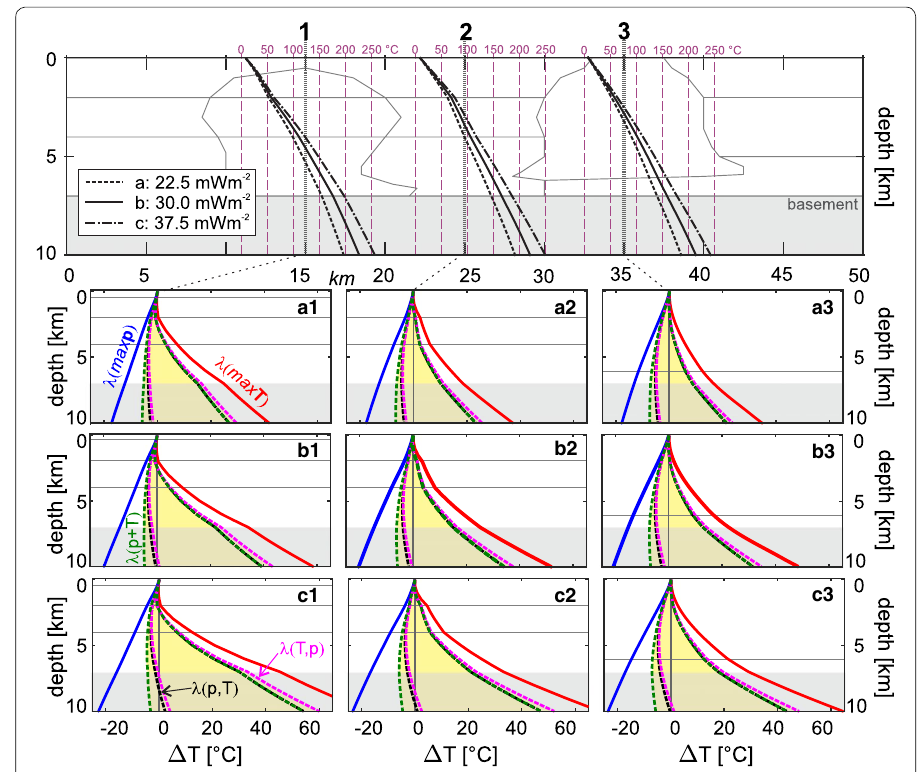
Fig. 5 Temperature profiles without correction of thermal conductivity (upper part) and temperature differences profiles (subfigures a1–c3) for scenario A (igneous section) at three different locations and for different basal heat flow in 30 km depth. Temperature differences are calculated against the uncorrected temperature profiles (relying on ambient thermal conductivities) based on different thermal conductivity ( λ ) correction methods: λ (max p )—maximum of pressure ( p ) correction on λ only, λ (max T )—maximum of temperature ( T ) correction on λ only (both as in Fig. 4); λ ( p , T )—combined correction of λ by correcting firstly for p and secondly for T , λ ( T , p )—combined correction of λ by correcting firstly for T and secondly for p ; λ ( p T )—combined correction of λ by adding the single p / T correction effects. Correction formulas for all + ways as shown in Table